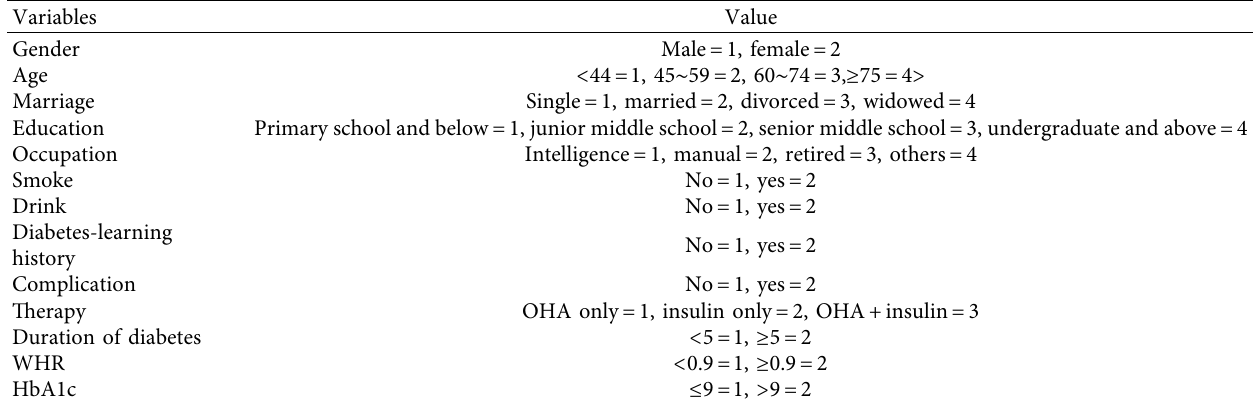
Table 5: Assigned values of independent variables.